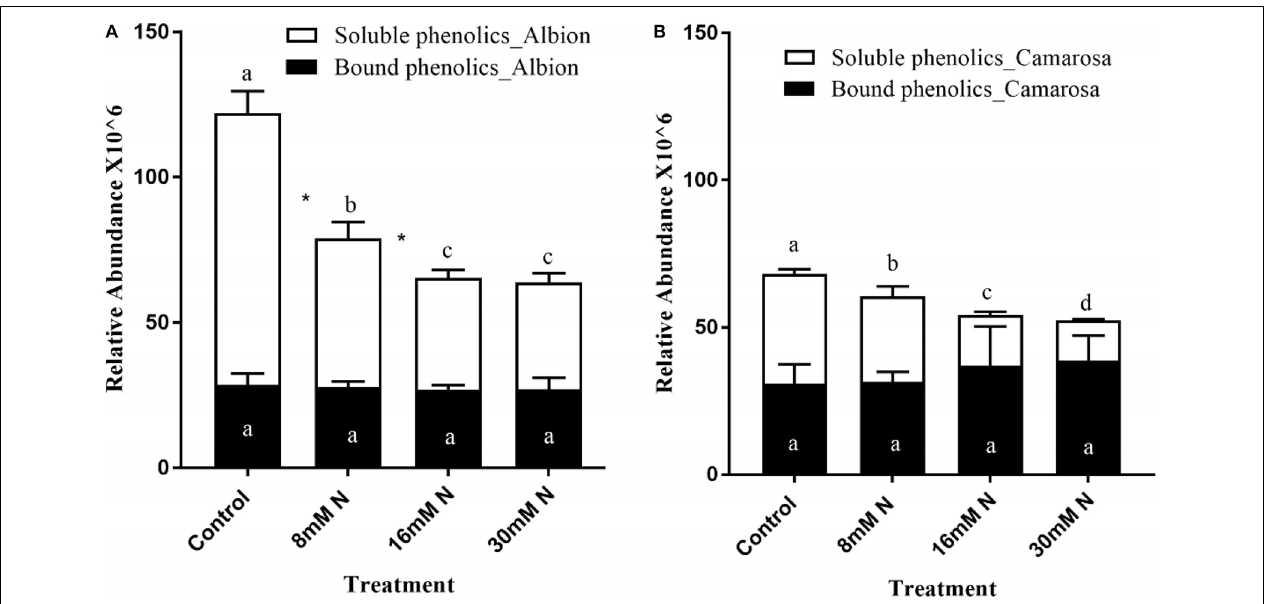
FIGURE 8 | Proportion of soluble vs. fiber-bound phenolics in Fragaria ananassa cv. Albion (A) and cv. Camarosa (B) exposed to four N treatments. The data represent the mean ± SD ( n = 5). Bars with the same letters are not significantly different at the 95% confidence interval. “*” Denotes statistical significance ( P < 0.05) between bound and soluble phenolics with a